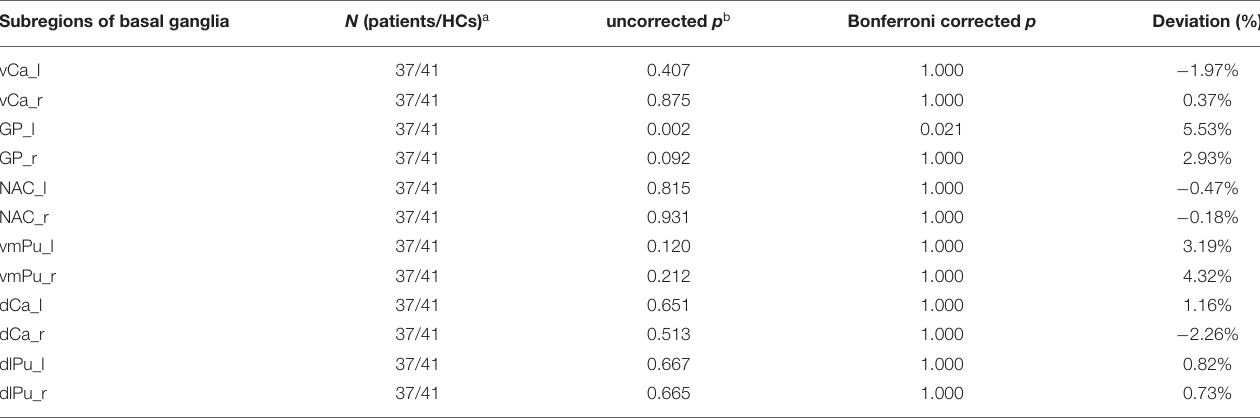
TABLE 4 | Changes in sub-regional volume of basal ganglia in OCD patients derived from Atlas-based analysis using Freesurfer. Subregions of basal ganglia N (patients/HCs) a uncorrected p b Bonferroni corrected p Deviation